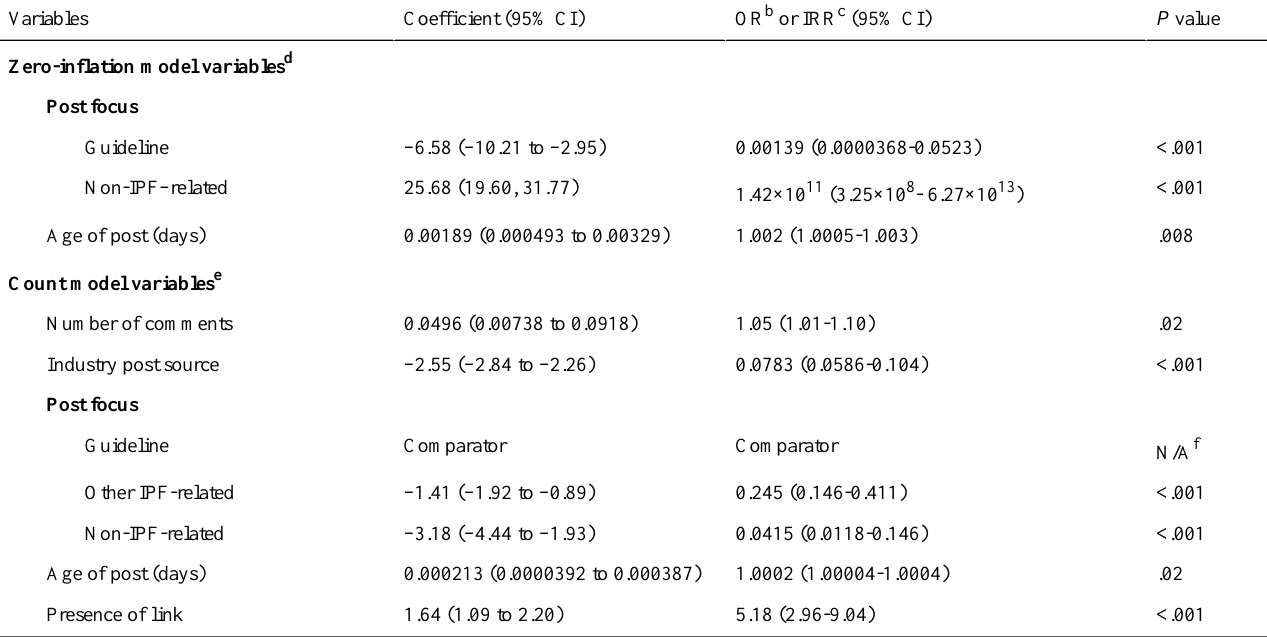
Table 3. Variables associated with content score in individual posts on adjusted analysis.